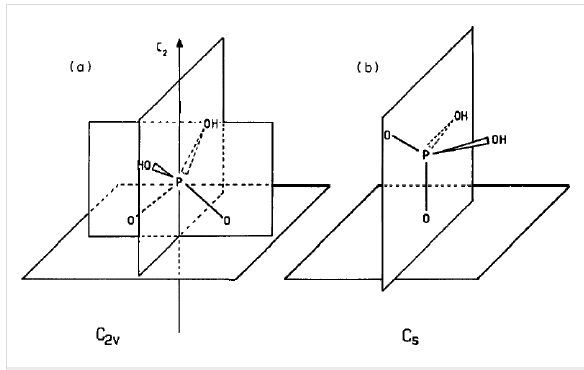
Figure 12: The H 2 PO 4 − ion under C 2 ν and C s symmetries. These are the most probable orientations of H 2 PO 4 − at low and high positive potentials, respectively. Reprinted with permission from [60]. Copy- right 1992